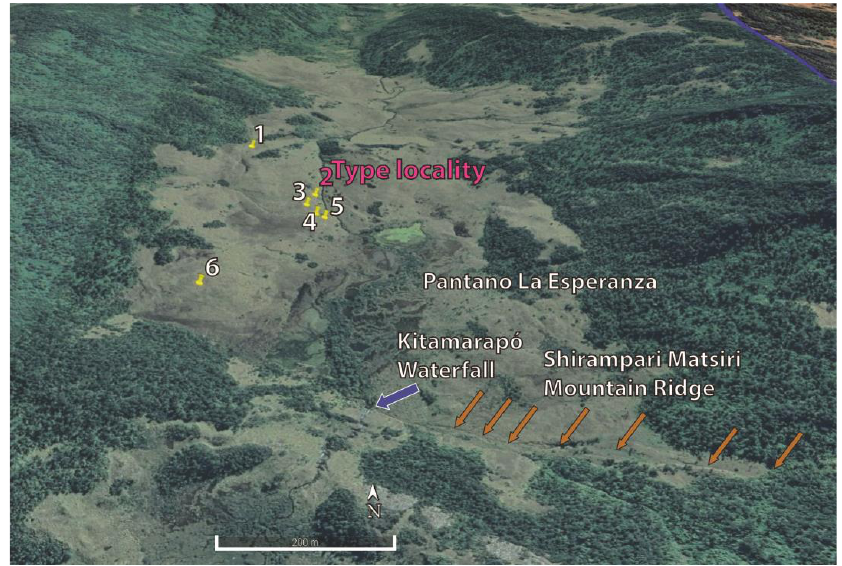
Figure 9. Google Earth image with collecting sites (yellow pins 1‒6) of Proctoporus titans sp. nov. The blue arrow marks the Kitamarapó Waterfall, and the brown arrows the Shirampari Matsiri Mountain Ridge.